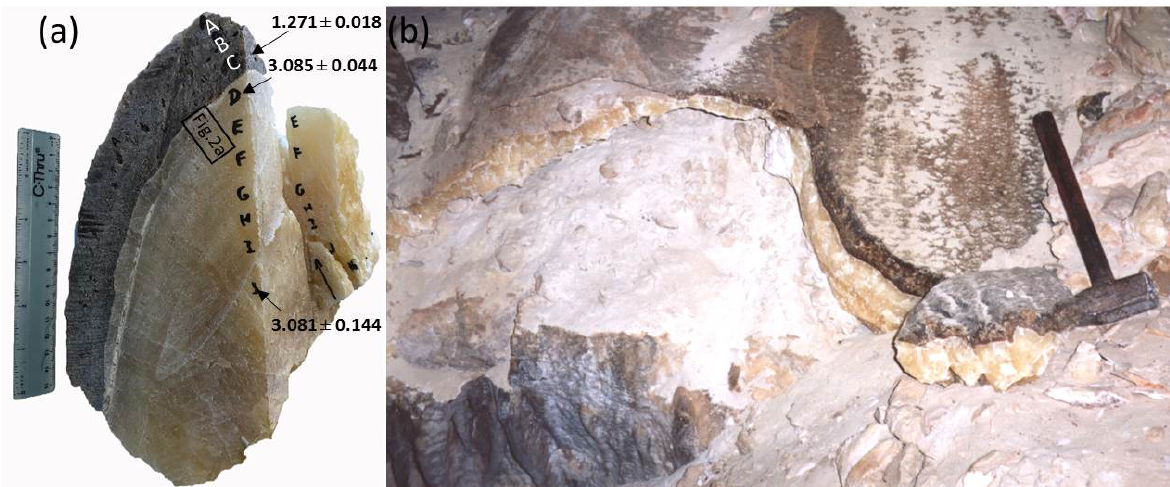
Figure 1. Sample ASH-15 from Ashalim Cave. (a) ≈ 5kg block of sample ASH-15 flowstone consisting of the massive Pliocene yellow basal layer ( > 2cm calcite crystals; section D–K) and the brown Quaternary layer (top section, A–C), the thin layer between the two stratigraphic members represents a growth break (hiatus). The main U − Pb ages of Vaks et al. (2013) are indicated. (b) In situ flowstone within Ashalim Cave from which ASH-15 was sampled, showing the large reservoir of this